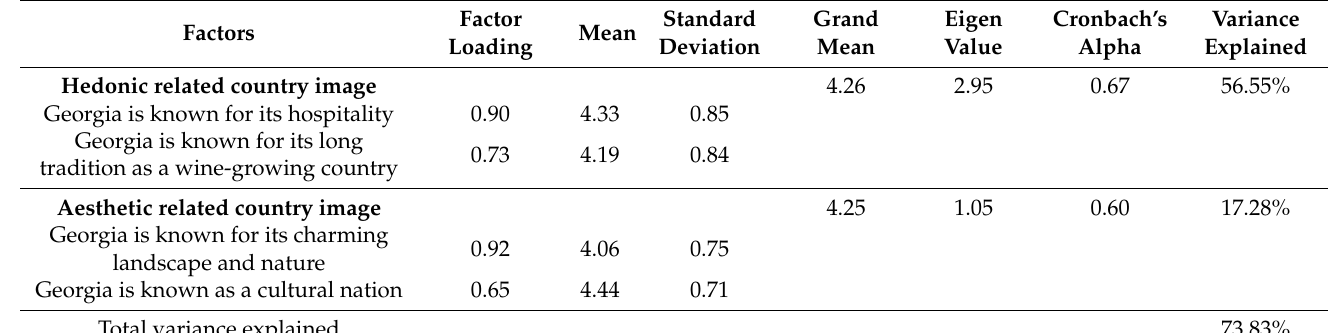
Table 2. Results of the factor analysis for the country